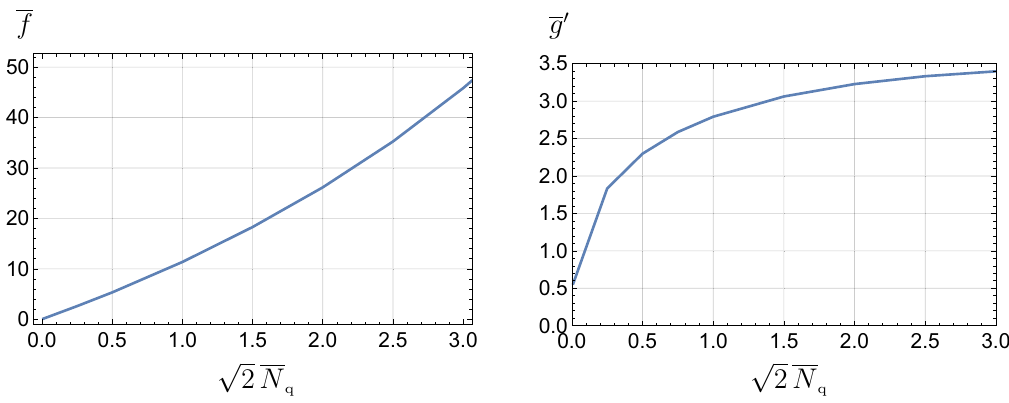
Figure 18 . Functions f and g